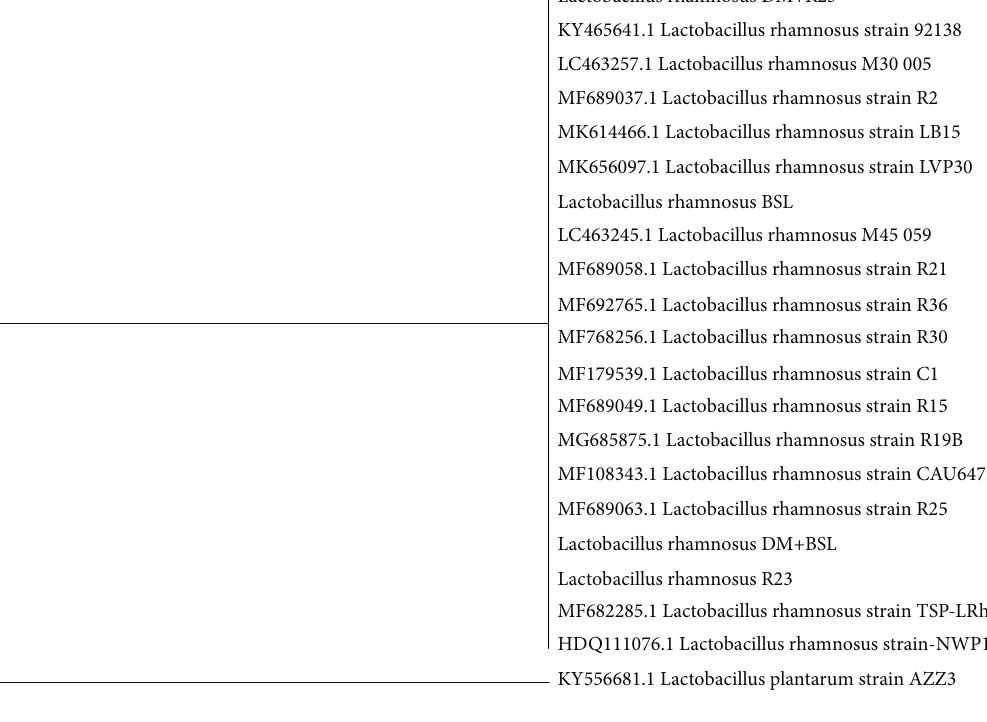
Figure 6: Position of the isolates in the neighbour joining phylogenetic tree based on 16S rRNA gene